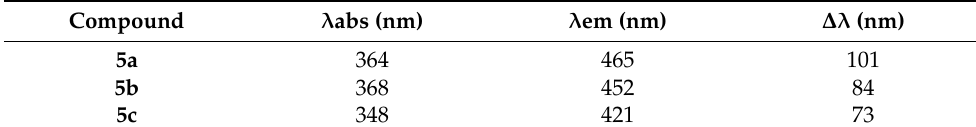
Table 1. Optical properties of compounds 5a–c . All compounds were excited at their absorbance λ max values.